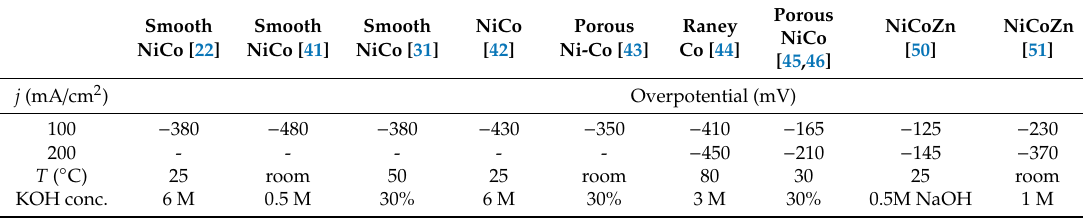
Table 2. Summary of NiCo alloys found in literature for HER in alkaline conditions.